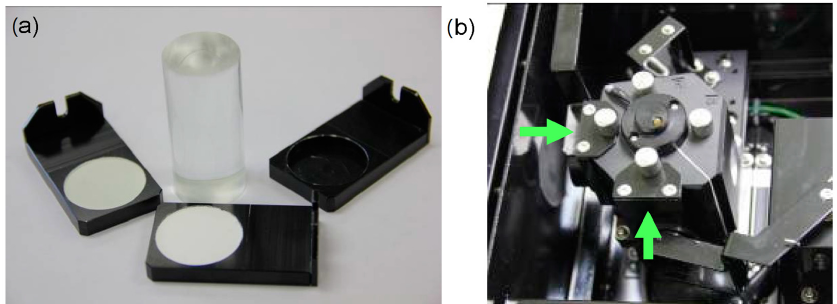
Figure 6. The photo of ( a ) the measuring cell and the glass cylinder used to form tablets and ( b ) the UV-VIS-NIR integrating sphere attachment ISR-3100 with the installed measuring cells. UV-VIS-NIR integrating sphere attachment ISR-3100 with the installed measuring